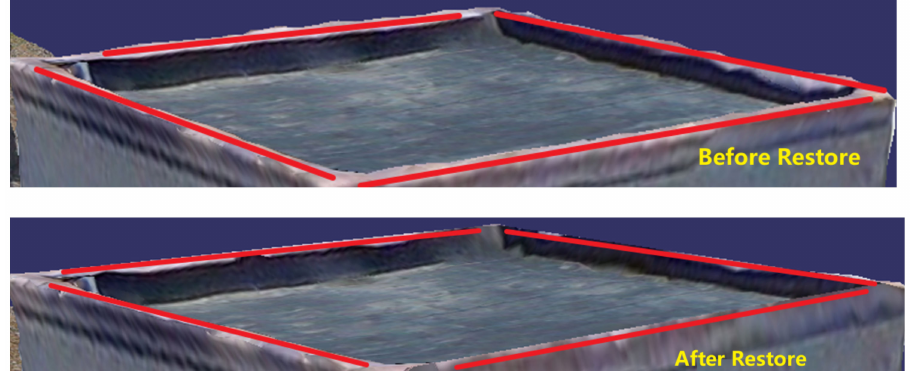
Figure 11. Comparative diagram of before and after edge